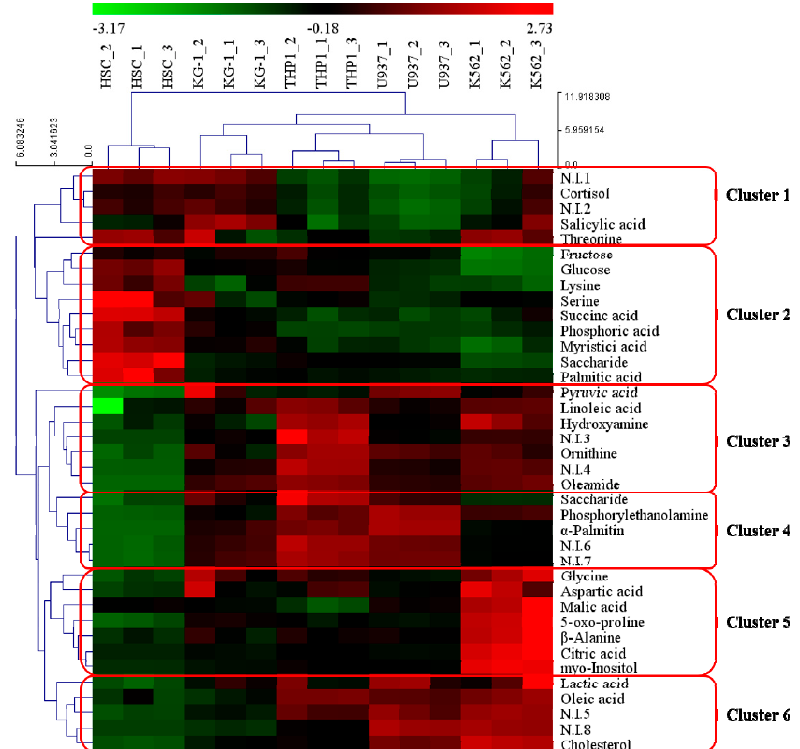
Figure 2. Heatmap showing hierarchical clustering analysis of metabolomic changes among four different leukemia cell lines and a normal hematopoietic stem cell (HSC) line. Metabolites were selected by VIP value > 0.7 and p value < 0.05. The rows display the metabolites, and the columns represent the cell lines. The colored squares (blue-to-red) represent fold changes normalized by averaging each metabolite of four different leukemia cells and a normal HSC line. The color scheme is as follows: lower limit value, − 3.17 (green); middle limit value, − 0.18 (black); upper limit value, 2.73 (red).